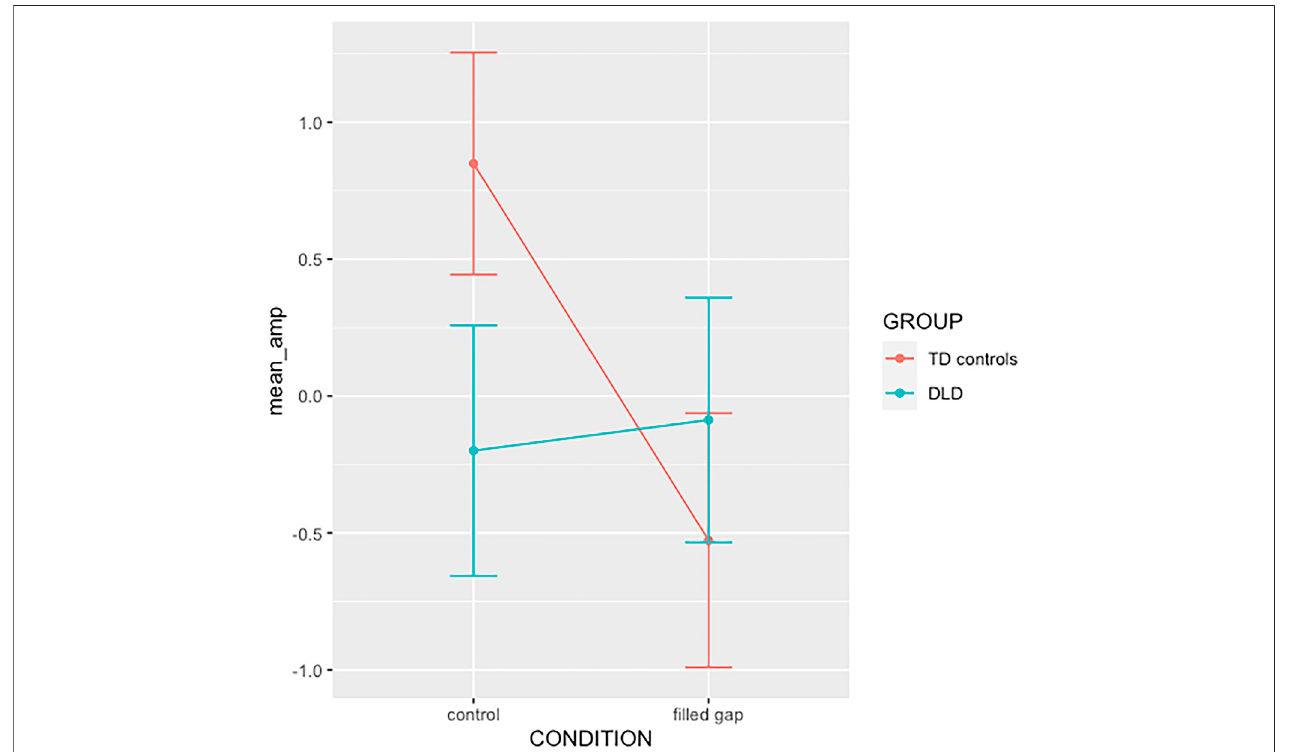
FIGURE 10 | Interaction plot for the 2x2 design GROUP x Condition interaction in TF04SF1. Error bar indicate standard error.